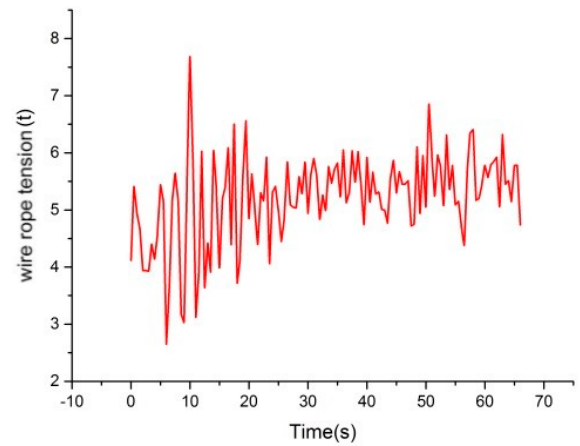
Figure 19. Data of universal pressure sensor.